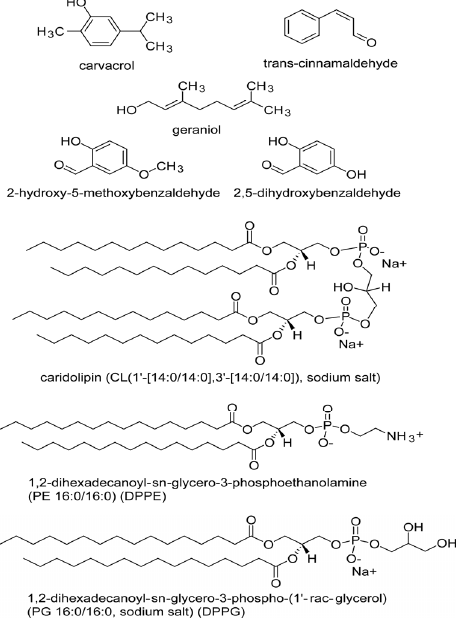
Figure 1. Structures of evaluated five test compounds and three